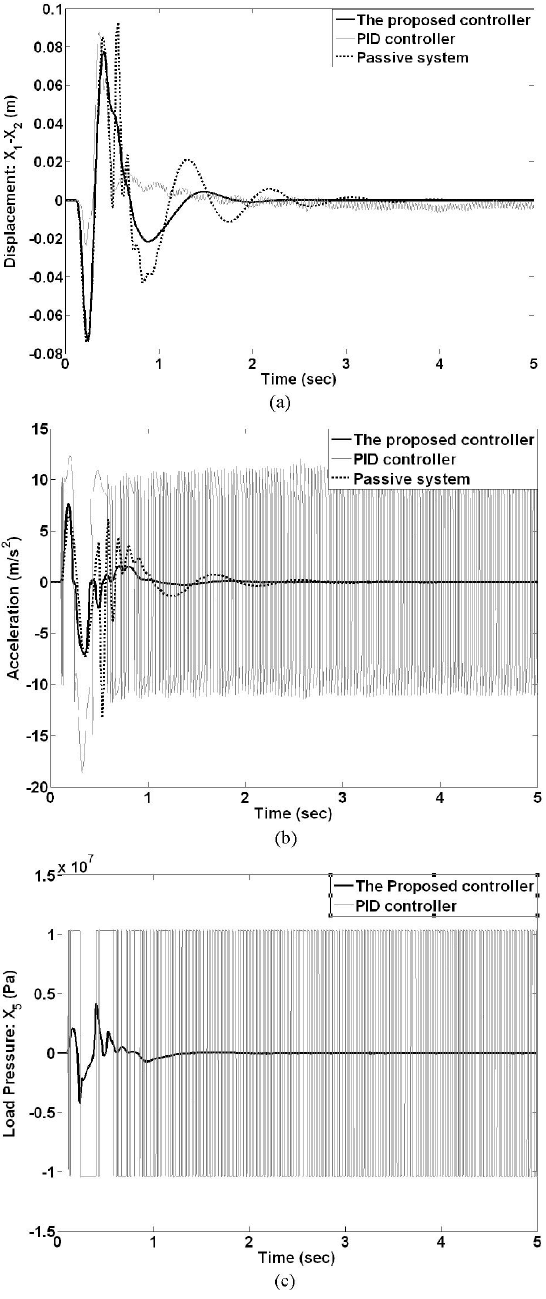
Figure 10. The system with nominal parameters is imposed by ran- dom road profile depicted in Fig. 4. (a) Suspension travel for the proposed controller, PID and passive suspension system, (b) Ver- tical vehicle body acceleration for the proposed controller, PID and passive suspension system, (c) Load pressure for the proposed controller and PID posed controller could have handled effectively the system owing to its free model base feature. In contrast, the ra- tios of PID to proposed controller parameter results